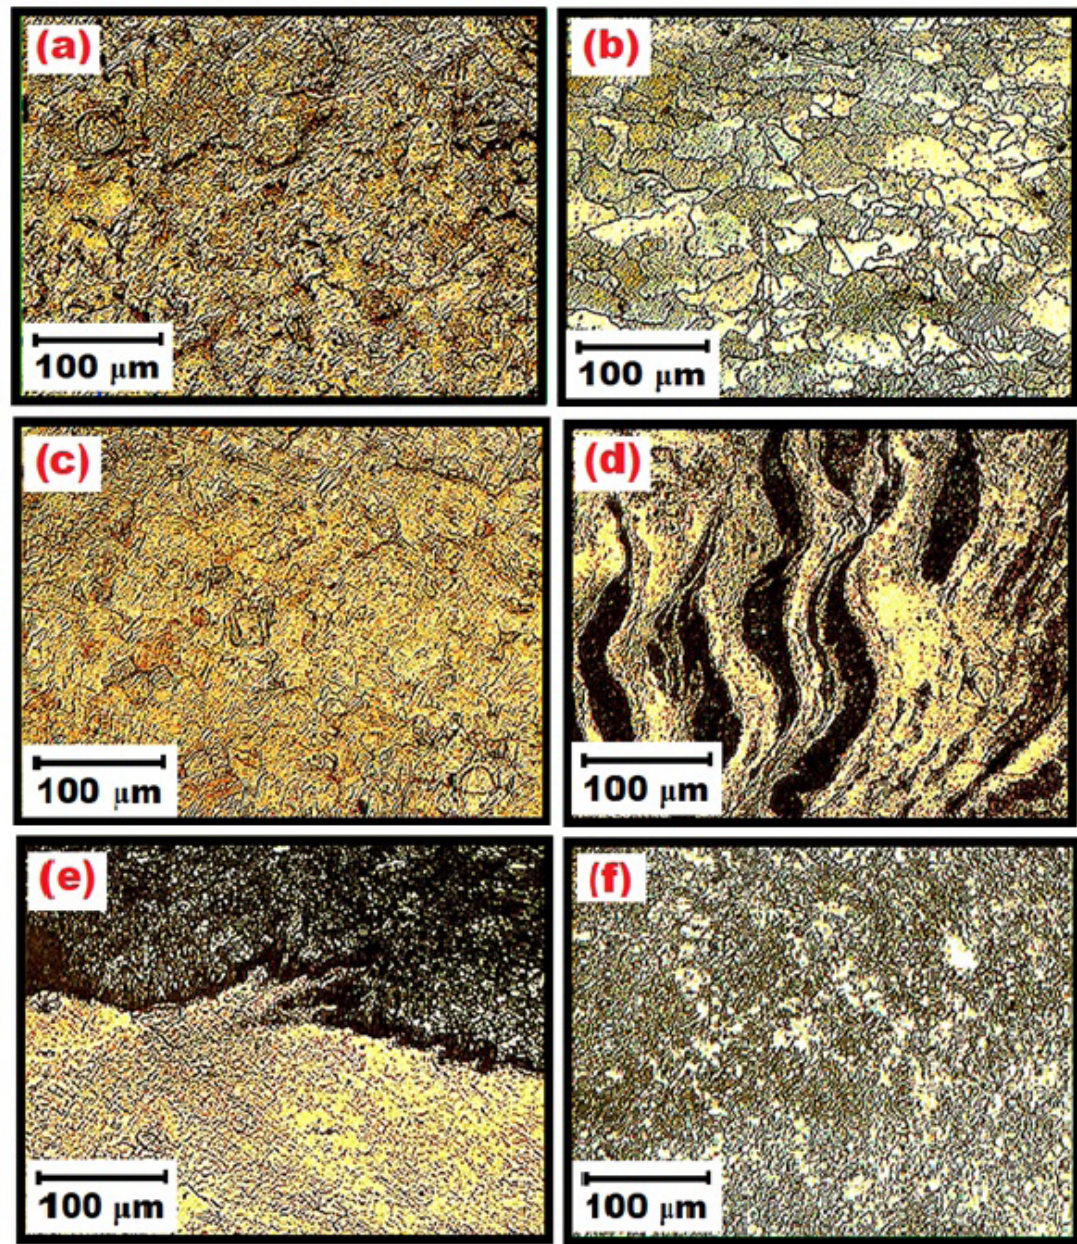
Figure 6. Microstructure of FSW joint of copper and LCS: (a) Cu–parent, (b) steel–parent, (c) Cu HAZ, (d) Cu TMT, (e) Cu–interface, and (f)